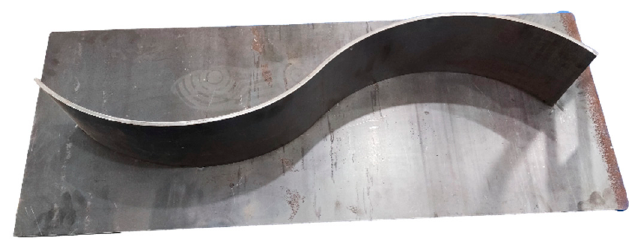
Figure 12. S-shaped weldment.